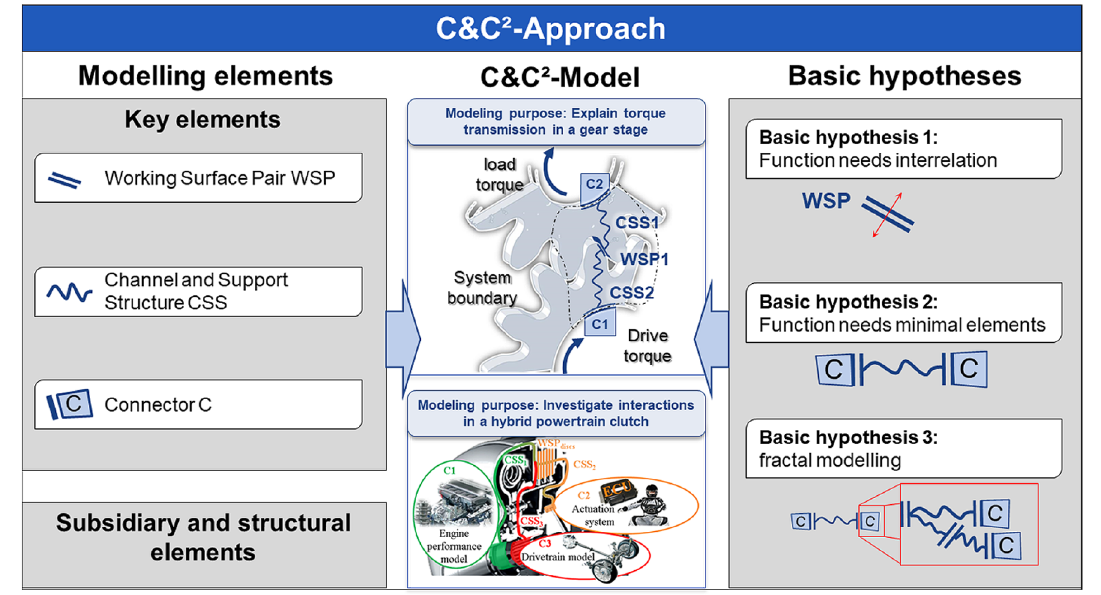
Fig. 3 Overview of the C&C 2 -Approach according to [31] extended with a model of